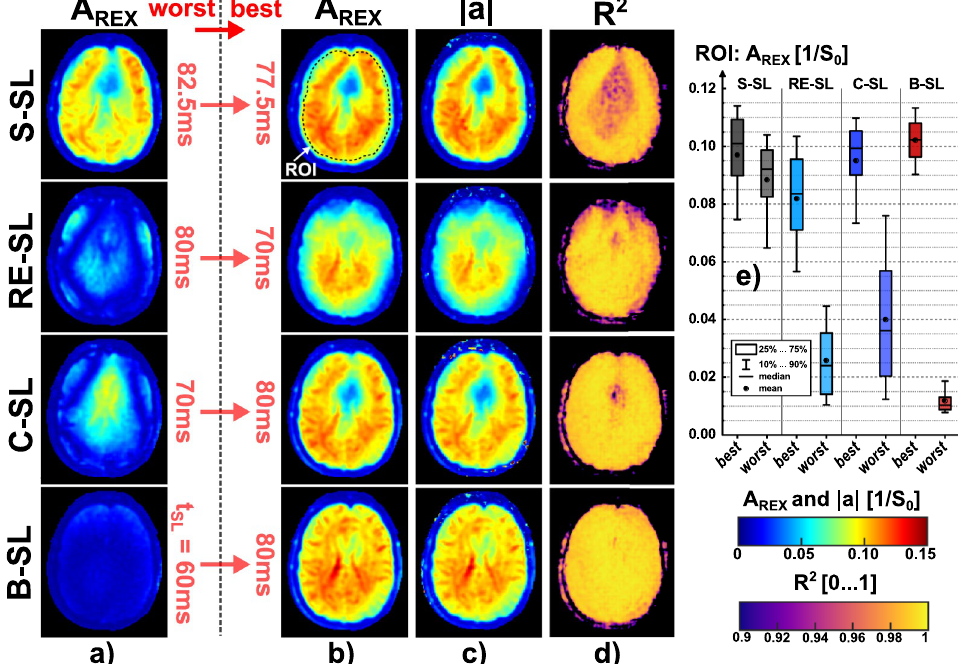
Figure 8. In vivo comparison of results for t REX measurements with worst and best case choice of spin-lock pulse duration t SL . Except for the spin-lock duration, the identical sequence parameters as for Fig. 7 were used. ( a ) The A REX results of the four modules with the respective worst choice of pulse duration. ( b ) Displays the corresponding best case measurements. ( c , d ) depict the REX fit results of |a| and the corresponding R 2 . The parameters A REX and |a| show high agreement. A ROI-based evaluation of A REX in brain tissue is presented in the box plot in ( e ). Especially for RE-SL, C-SL and B-SL, the high relevance of the pulse duration choice is evident. In case of an unsuitable choice, A REX can be substantially reduced. For the S-SL module, as expected from the simulation results, there is no pronounced difference between best and worst settings. However, significant differences are also evident in the best case experiments for the compensated modules. Here, all modules except B-SL show reduced A REX values near the cranial bone (RE-SL) or the frontal sinus (S-SL and C-SL). The overall best performance of B-SL is also evident in the R 2 maps. The remaining fitted parameter maps and the results of B 0 and B + 1 mapping are presented in the Supplementary